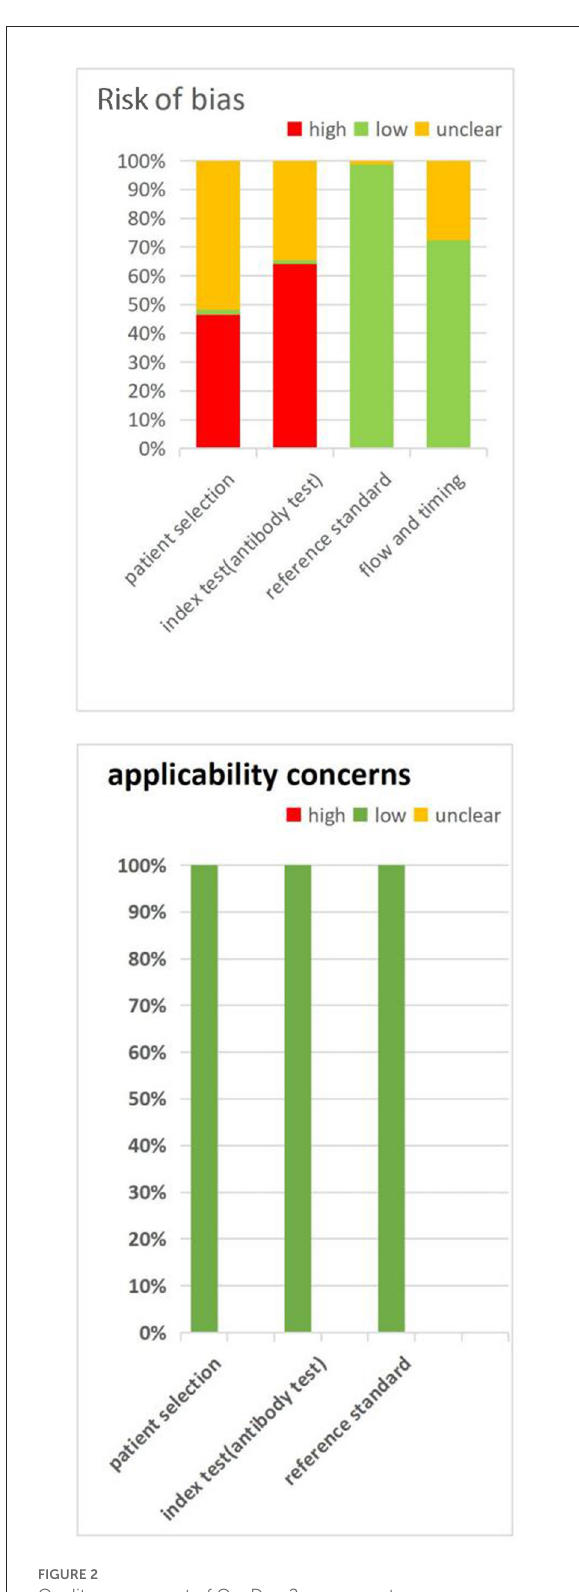
FIGURE2 Quality assessment of QuaDas-2